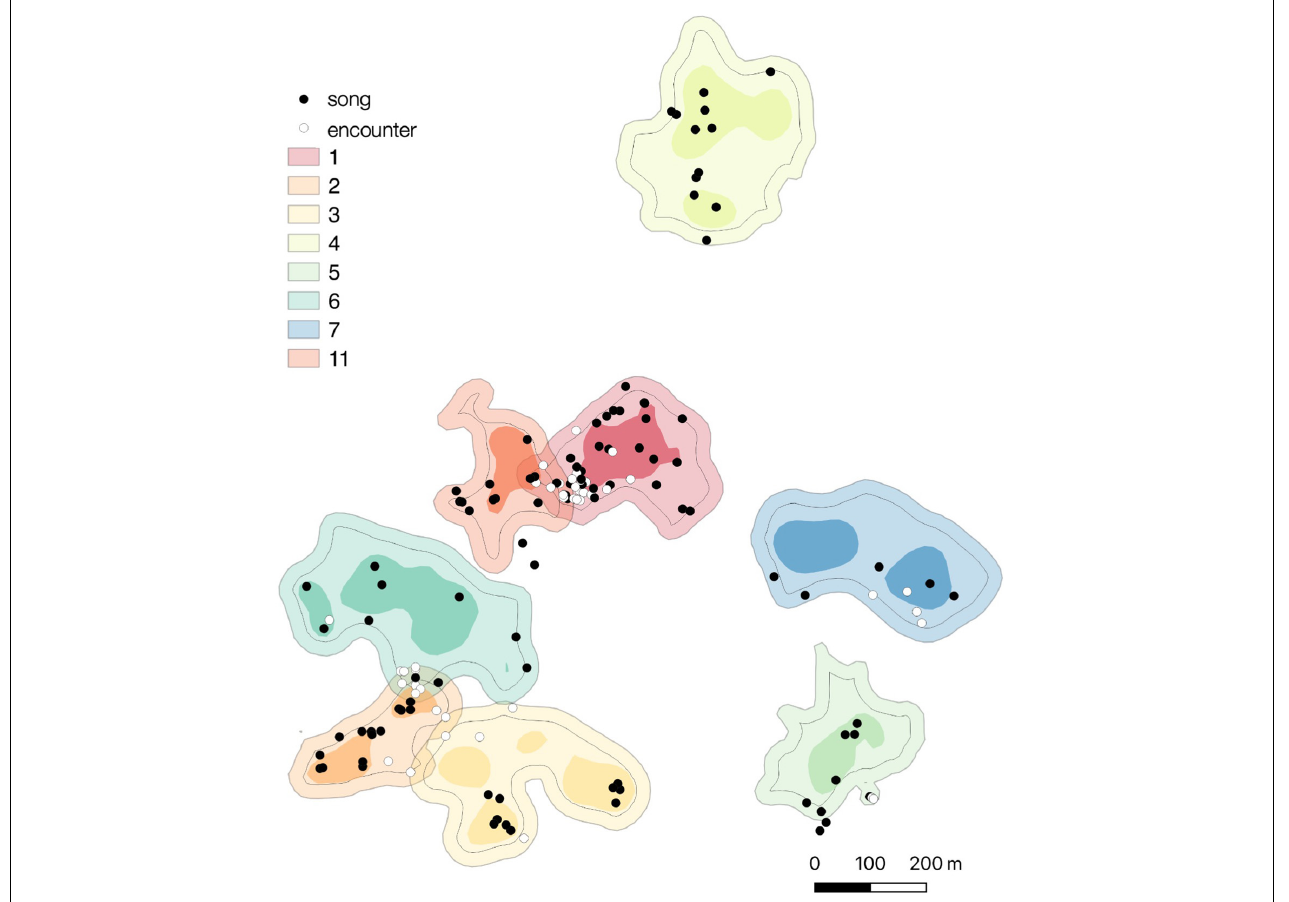
FIGURE 4 | Spatial distribution of songs produced in the intergroup encounter context (white dots) and non-intergroup encounter contexts (black dots) for eight study groups. Light areas depict the 95% fixed kernel home ranges, darker areas depict the 50% fixed kernel core areas. Black lines within each home range depict 25-m inner border